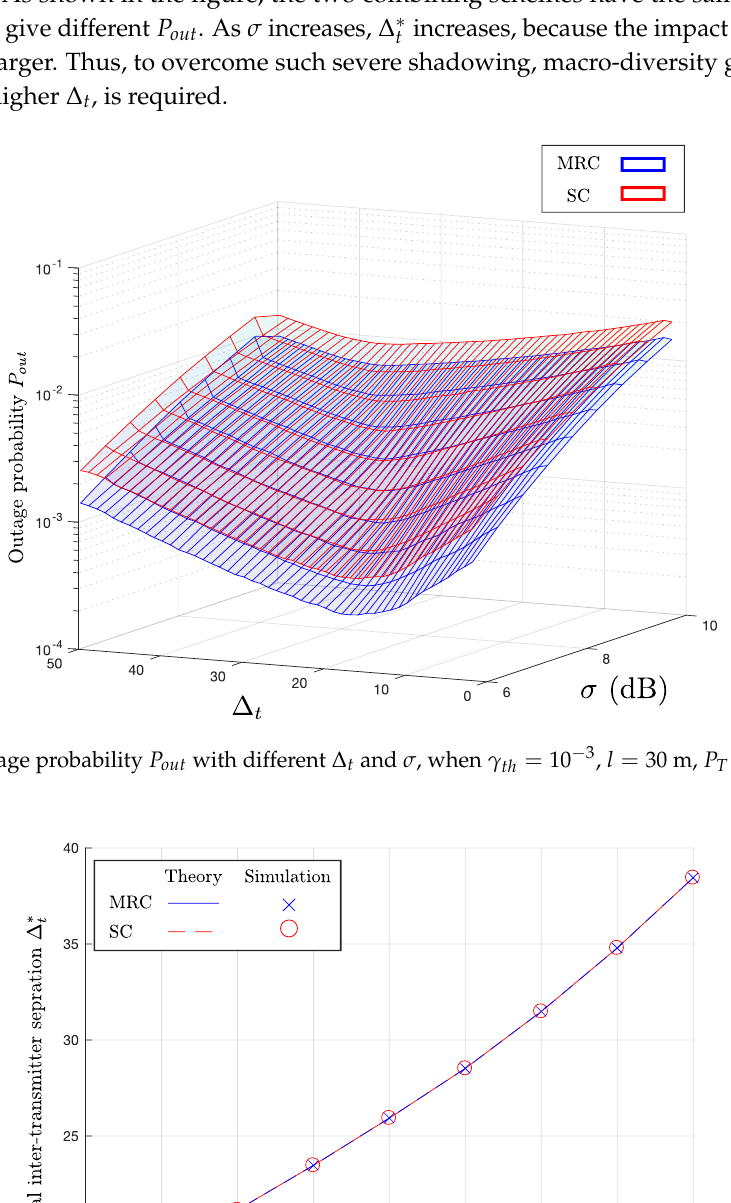
σ , when γ th = 10 − 3 , l = 30 m, P T = 50 dB, t versus